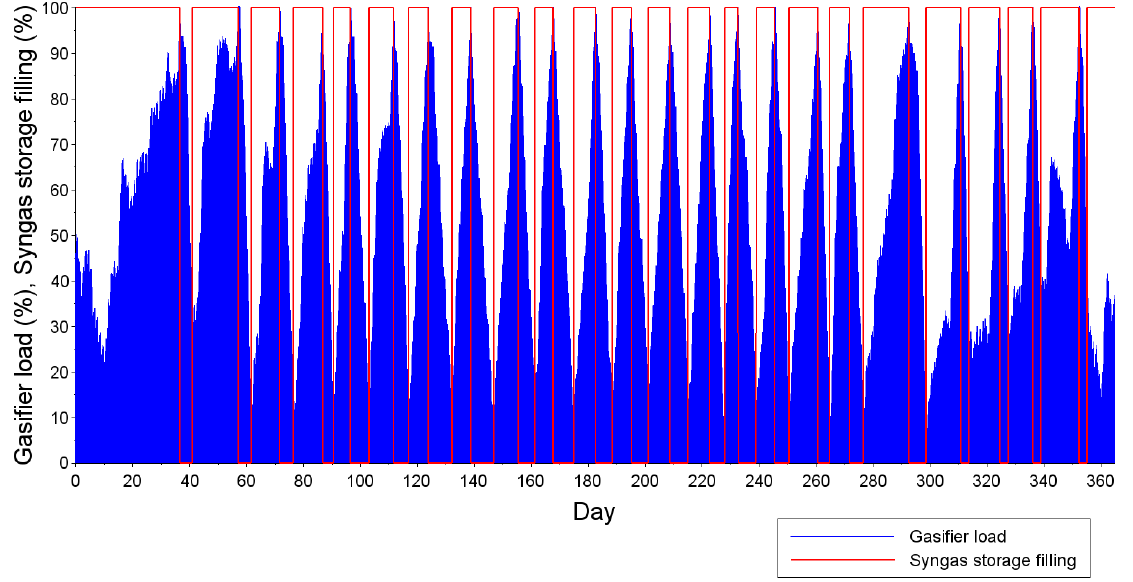
Figure 9. Diagram of the gasifier load and gas storage filling for the RES nominal power of 10 MW.